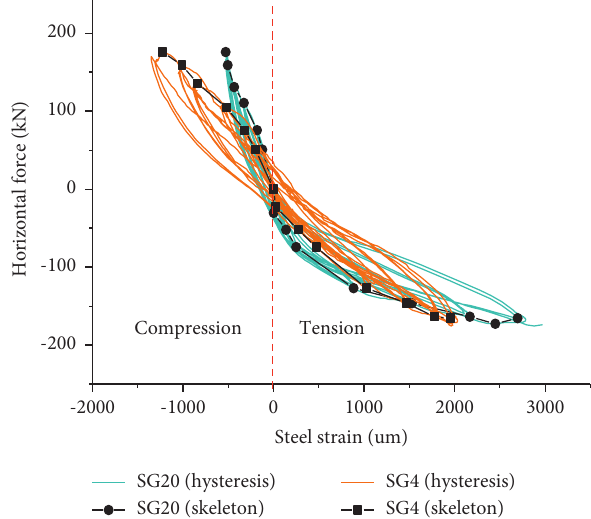
Figure 21: Hysteresis and skeleton curves of rebar strains above and below the type-II sleeve in YZ2.